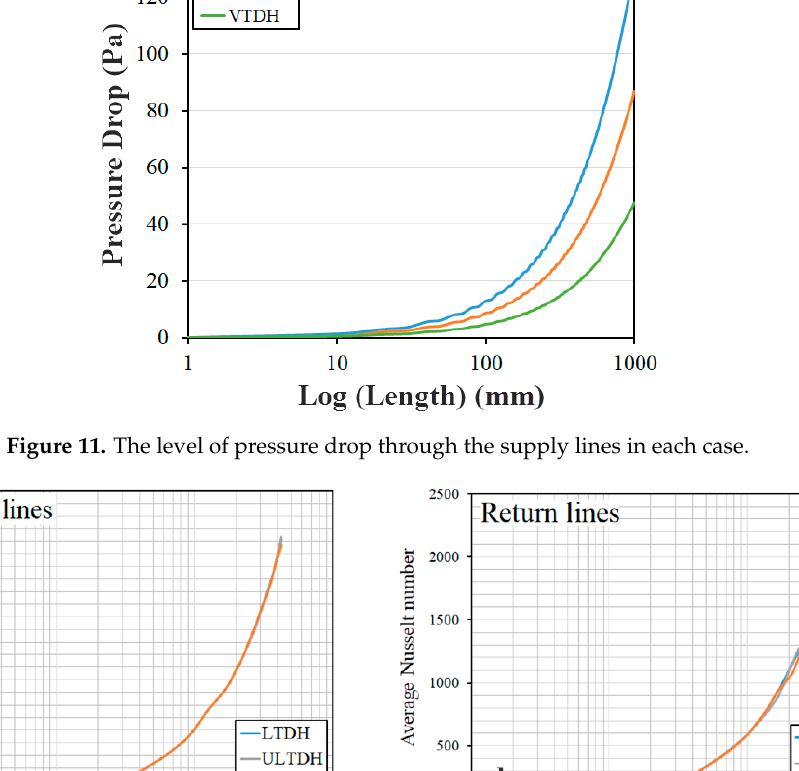
Figure 12. The effect of Reynolds number on the Nusselt number through the pipes in each case. ( a ) supply lines; ( b ) return lines.